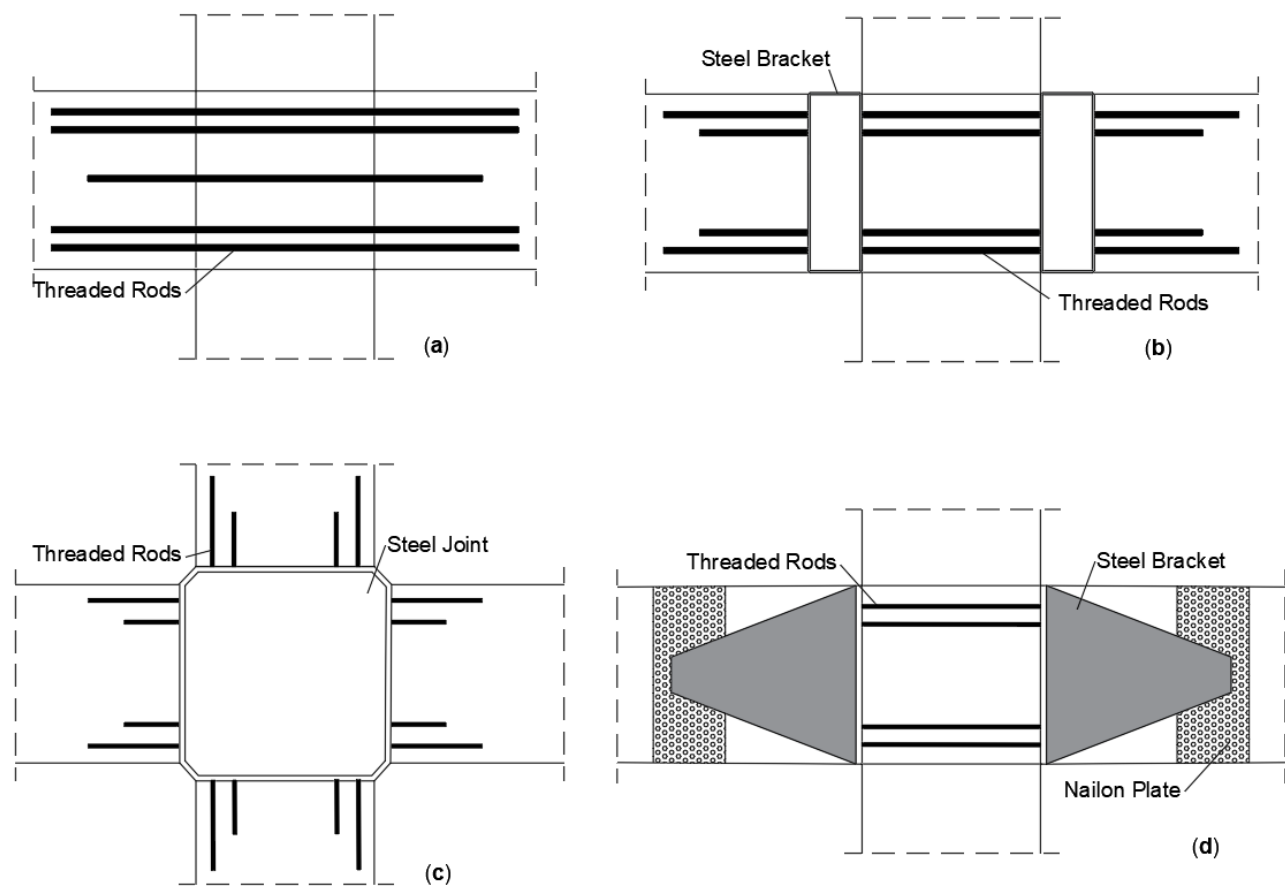
Figure 16. Moment-resisting glulam connections tested by [43]. (adapted from Ref.